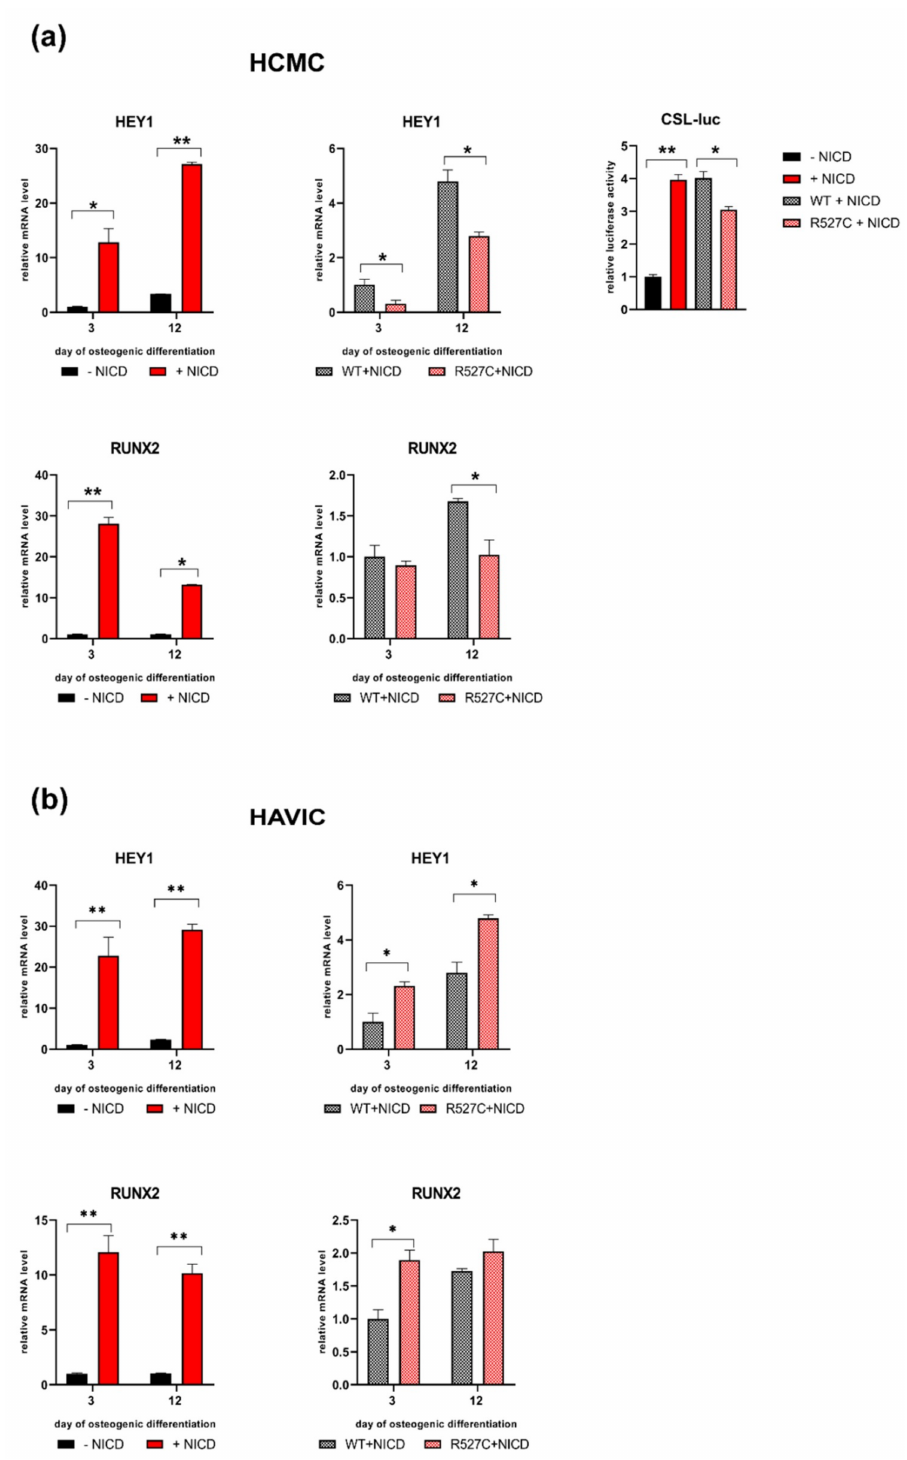
Figure 5. LMNA R527C mutation has the opposite effect on HCMC and HAVIC in the presence of Notch activation. ( a ) Upper panel: LMNA R527C affects Notch target gene expression in differentiated HCMC when Notch is activated. Osteogenic differentiation of HCMC was induced with/without Notch induction via transduction with lentivirus bearing Notch-intracellular domain (NICD) and